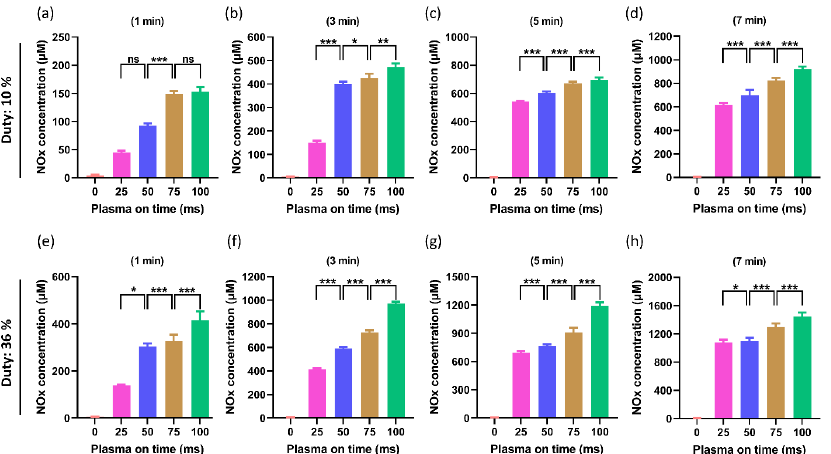
Figure 7. The NOx level in PTM. Only plasma on-time was altered as 25, 50, 75, and 100 ms in each treatment time and duty ratio. ( a – d ) The NOx content in PTM when the duty ratio was fixed at 10%. ( e – h ) The NOx levels when the duty ratio is maintained at 36%. It was found that the NOx levels significantly increased gradually by increasing the plasma on-time. The significance was calculated using Microsoft Excel (MS Office 365), while the differences between the treatment groups are indicated by * p < 0.05, ** p < 0.01, *** p < 0.001, ns—not significant.